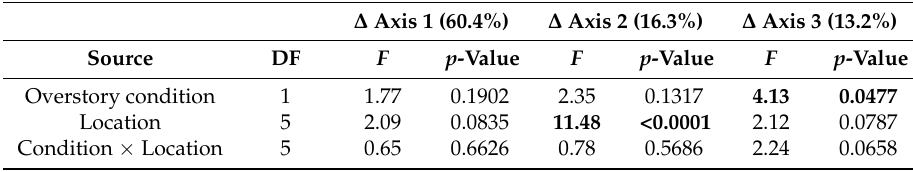
Table A2. Mixed effects ANOVA results for differences in axis scores between observed plots and open, harvested reference condition. Factor designations are as follows: Overstory condition, aggregate vs. intact forest; Location, distance ( ± m) from harvest edge; overstory X location, interaction between the two main factors. Bold text indicates statistical significance with p <